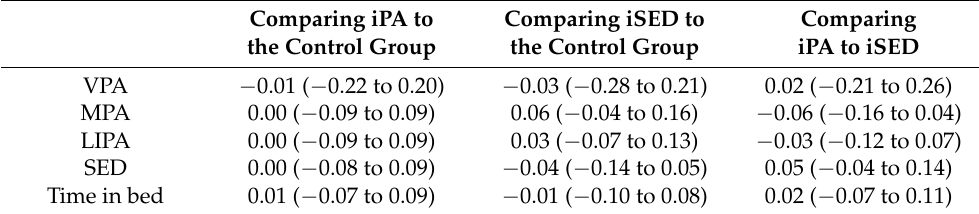
Table A1. Differences in change from baseline to follow-up between groups for movement behaviors (estimates with 95% CI), based on the linear mixed models. Comparing iPA to Comparing iSED to Comparing the Control Group the Control Group iPA to iSED VPA − 0.01 ( − 0.22 to 0.20) − 0.03 ( − 0.28 to 0.21) 0.02 ( − 0.21 to 0.26) MPA 0.00 ( − 0.09 to 0.09) 0.06 ( − 0.04 to 0.16) − 0.06 ( − 0.16 to 0.04) LIPA 0.00 ( − 0.09 to 0.09) 0.03 ( − 0.07 to 0.13) − 0.03 ( − 0.12 to 0.07) SED 0.00 ( − 0.08 to 0.09) − 0.04 ( − 0.14 to 0.05) 0.05 ( − 0.04 to 0.14) Time in bed 0.01 ( − 0.07 to 0.09) − 0.01 ( − 0.10 to 0.08) 0.02 ( − 0.07 to